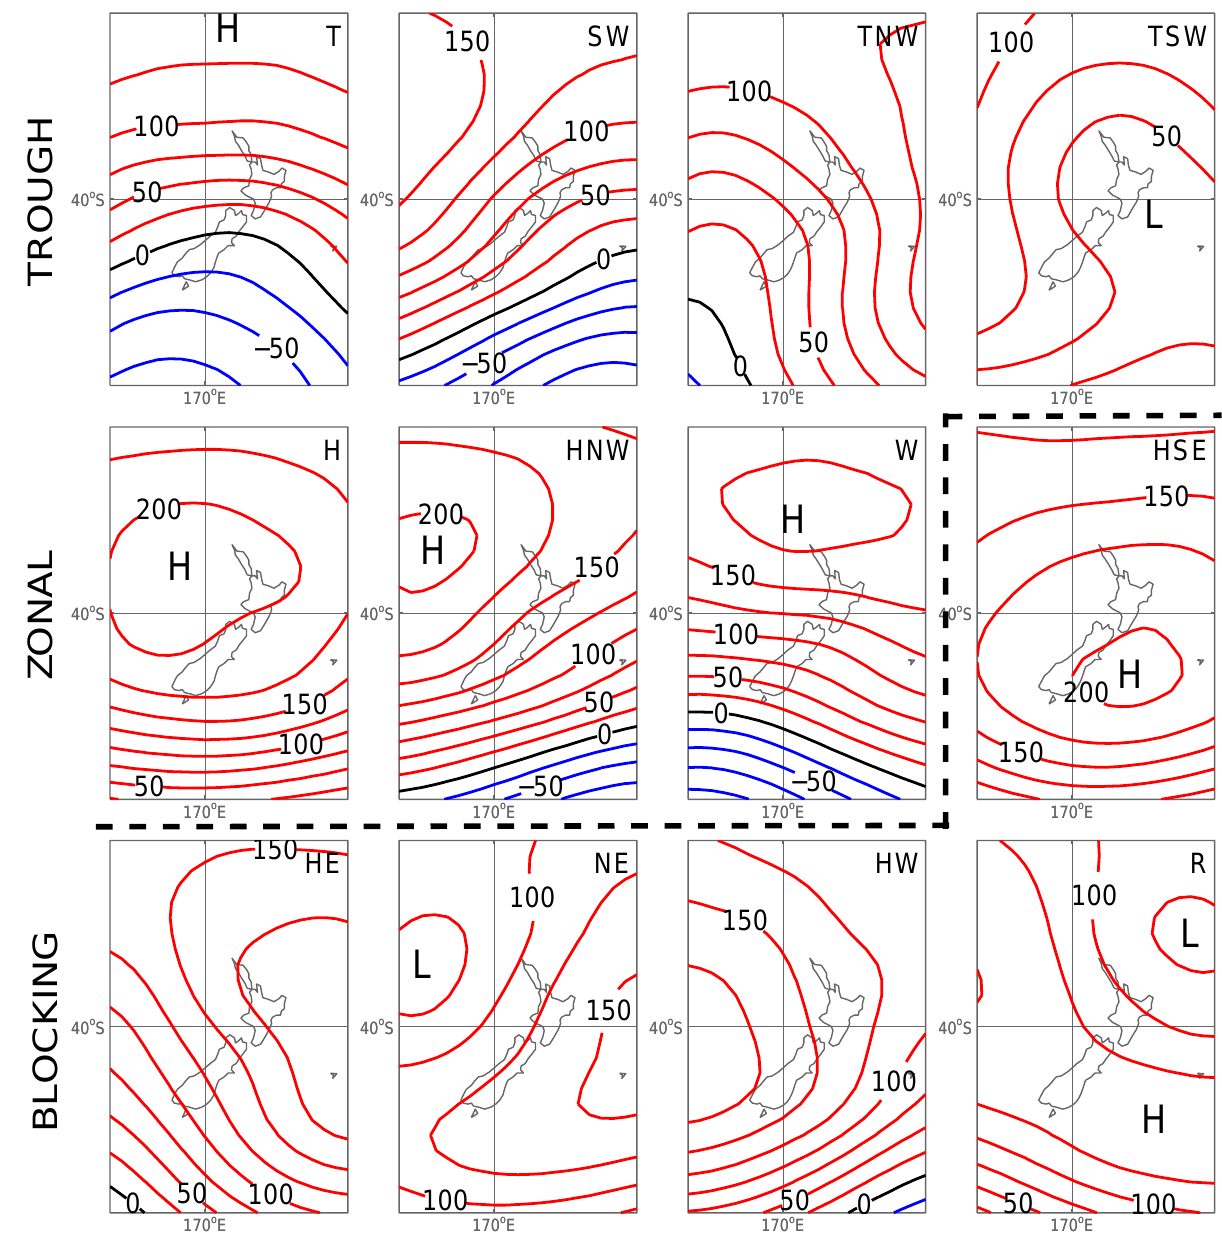
Fig. 1. The twelve Kidson weather types, shown as average patterns of 1000hPa geopotential height (analogous to mean sea-level pressure). Names for the types are indicated in the top right of each panel (see text for details). The three regimes are indicated at the left: the top row is the trough regime, the first three in the second row are the zonal regime, and the rest form the blocking regime. See Kidson (2000) for further